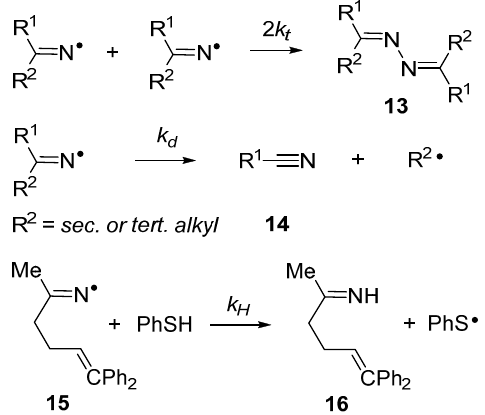
Scheme 3. Combination, dissociation and H-atom abstraction reactions of iminyl radicals.